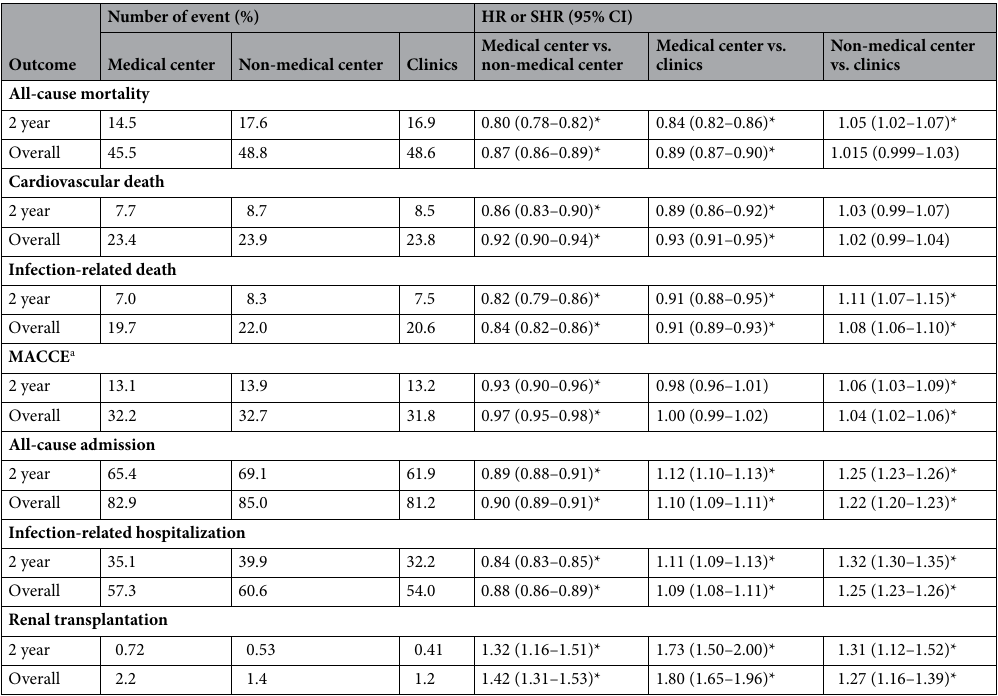
Table 3. Outcome of the patients according to the dialysis facility level during the follow up after IPTW. HR hazard ratio, SHR subdistribution hazard ratio, CI confidence interval, MACCE major adverse cardiac and cerebrovascular events. Data were presented as percentage. * P value < 0.05; a Including acute myocardial infarction, acute ischemic stroke and cardiovascular death.